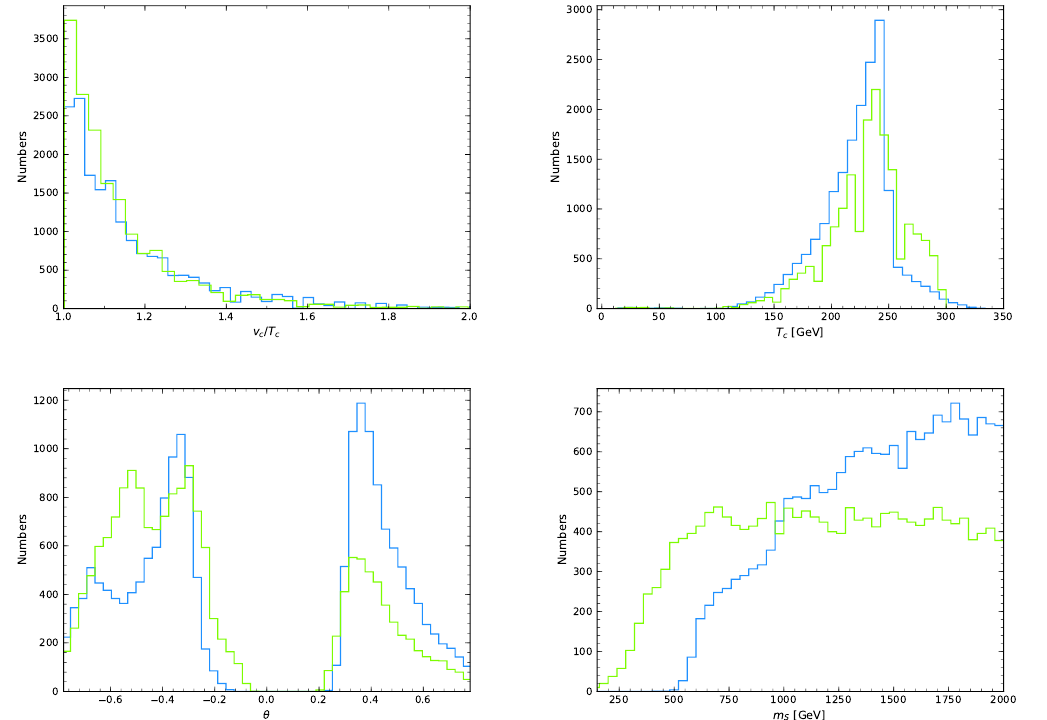
Figure 13 . The upper two plots give the distributions in v c =T c and T c and the lower two plots give the distributions in (cid:18) and m S that can generate a su(cid:14)ciently strong (cid:12)rst-order EWPT. The blue and green histograms represent the random parameter scan results obtained in the Landau gauge potential and the gauge-independent potential,